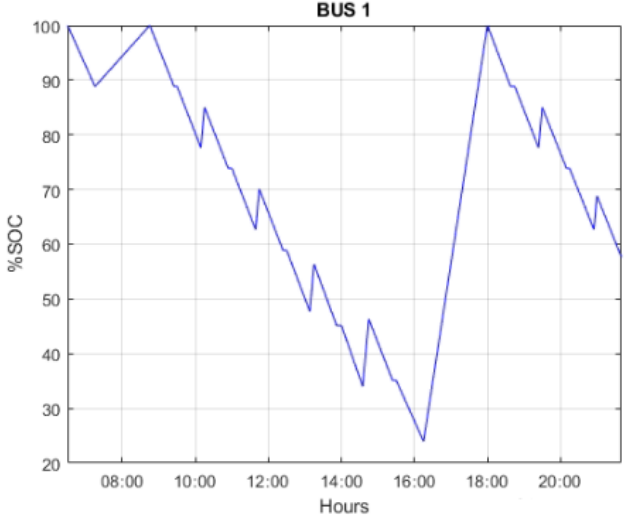
Figure 21. SOC of Bus 1, which runs Line M-150.